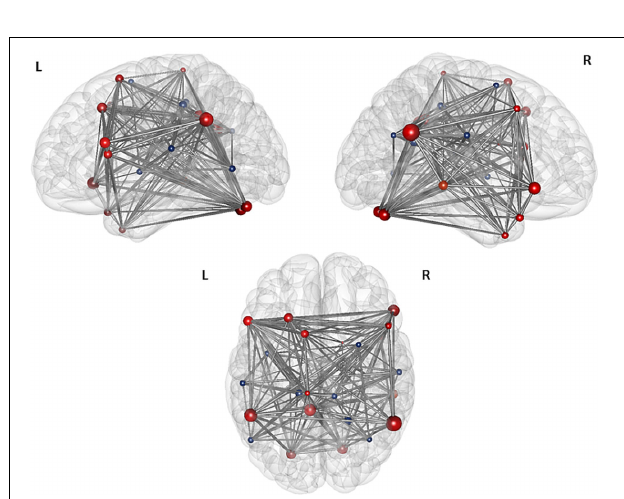
FIGURE 5 | Illustration of the modules after the first level modularity analysis. The figure illustrates the result of the first partition of the 25 nodes network from top, left, and right orientation. The size of the nodes represents their global efficiency. The edges illustrate the t -values of all of the associations. The nodes that are positively correlated with the two original seeds are shaded red, the nodes that are negatively correlated with the original seeds are shaded